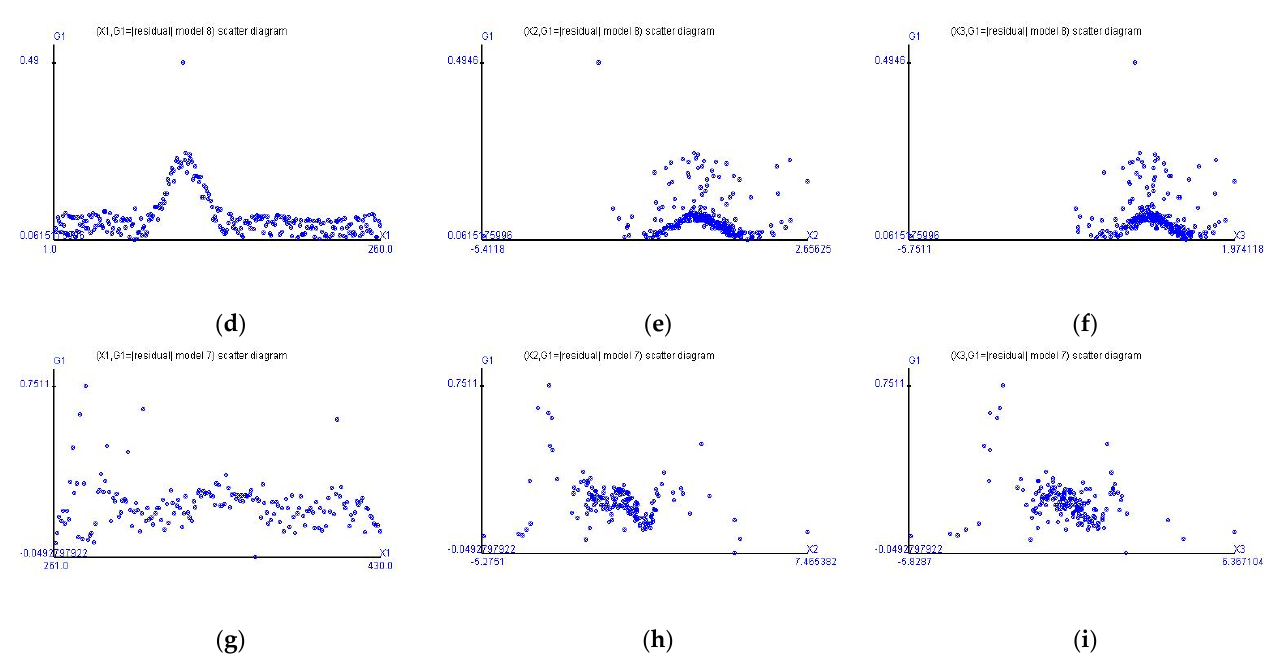
( h ) ( i ) Figure A1. The fitted values of the heteroscedastic estimation. ( a – c ) is Case 1; ( d – f ) is Case 2; and ( g – i ) is Case 3.